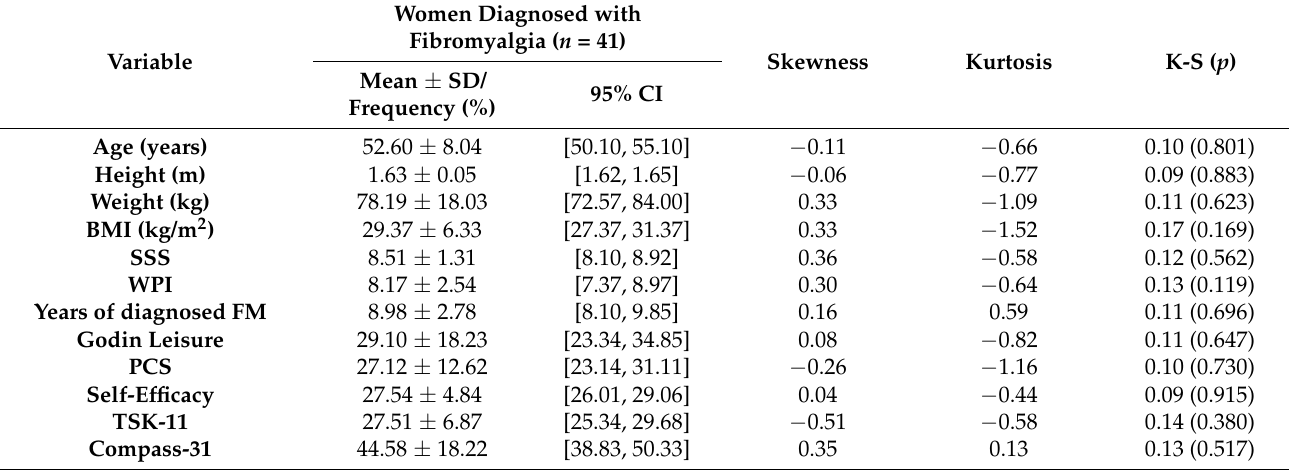
Table 1. Summary of sociodemographic data of the women diagnosed with